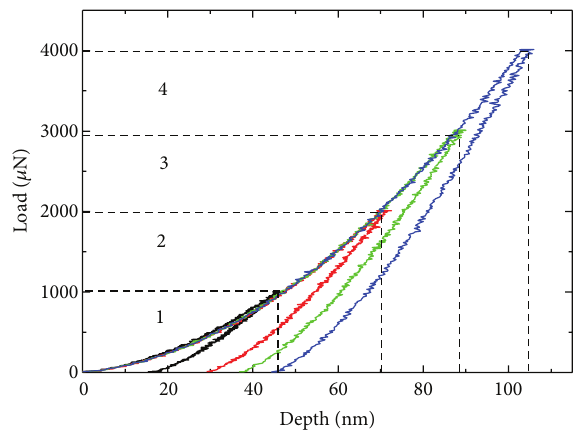
Figure 2: Load-displacement relationship of LS SiN sample during nanoindentation.